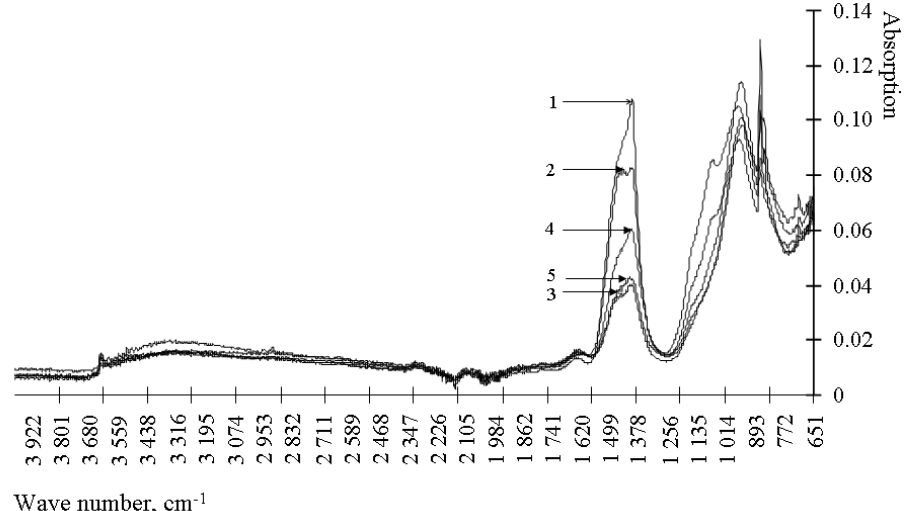
Figure 4. IR spectra of cement stone modified with barium hydrosilicates and zinc hydrosilicates (0.5%): 1—at the age of 1 day; 2—at the age of 3 days; 3—at the age of 7 days; 4—at the age of 14 days; 5—at the age of 28 days. Table 2. Intensity of IR spectrum.